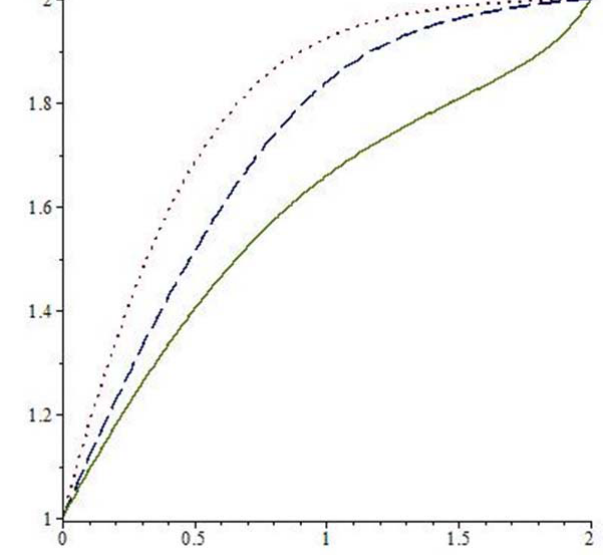
Figure 3. Function (cid:1834)(cid:4666)(cid:1875)(cid:4667) when (cid:1858) (cid:3404) (cid:3398)(cid:4666)(cid:1876) (cid:3397) (cid:1877)(cid:4667) and (from left to right) ϵ = 0.5, 0.25 and 0.2.